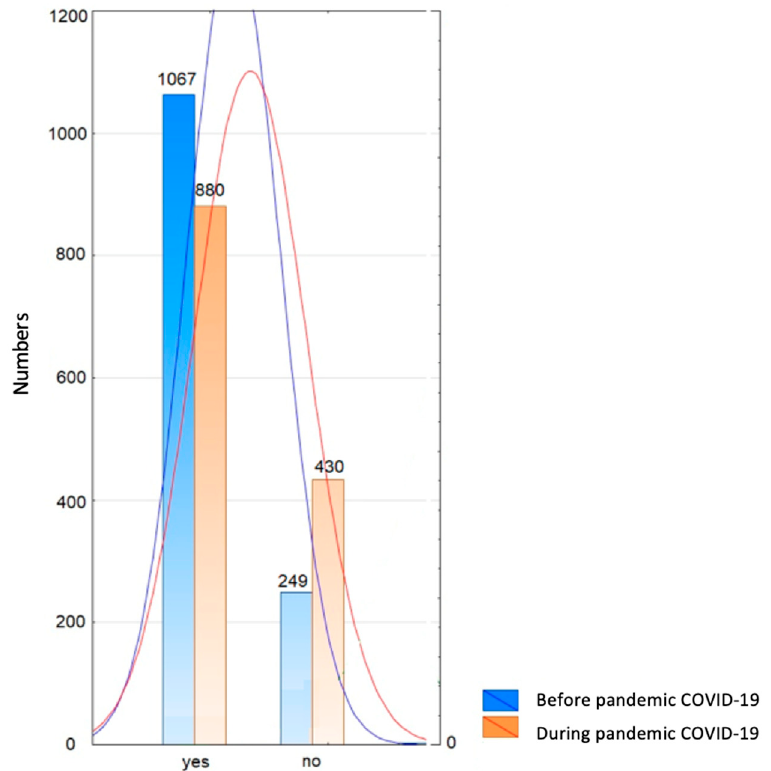
Figure 2. Number distribution of active and inactive children aged 3–5 years before and during the pandemic (yes—actively spent time; no—time not actively spent) .